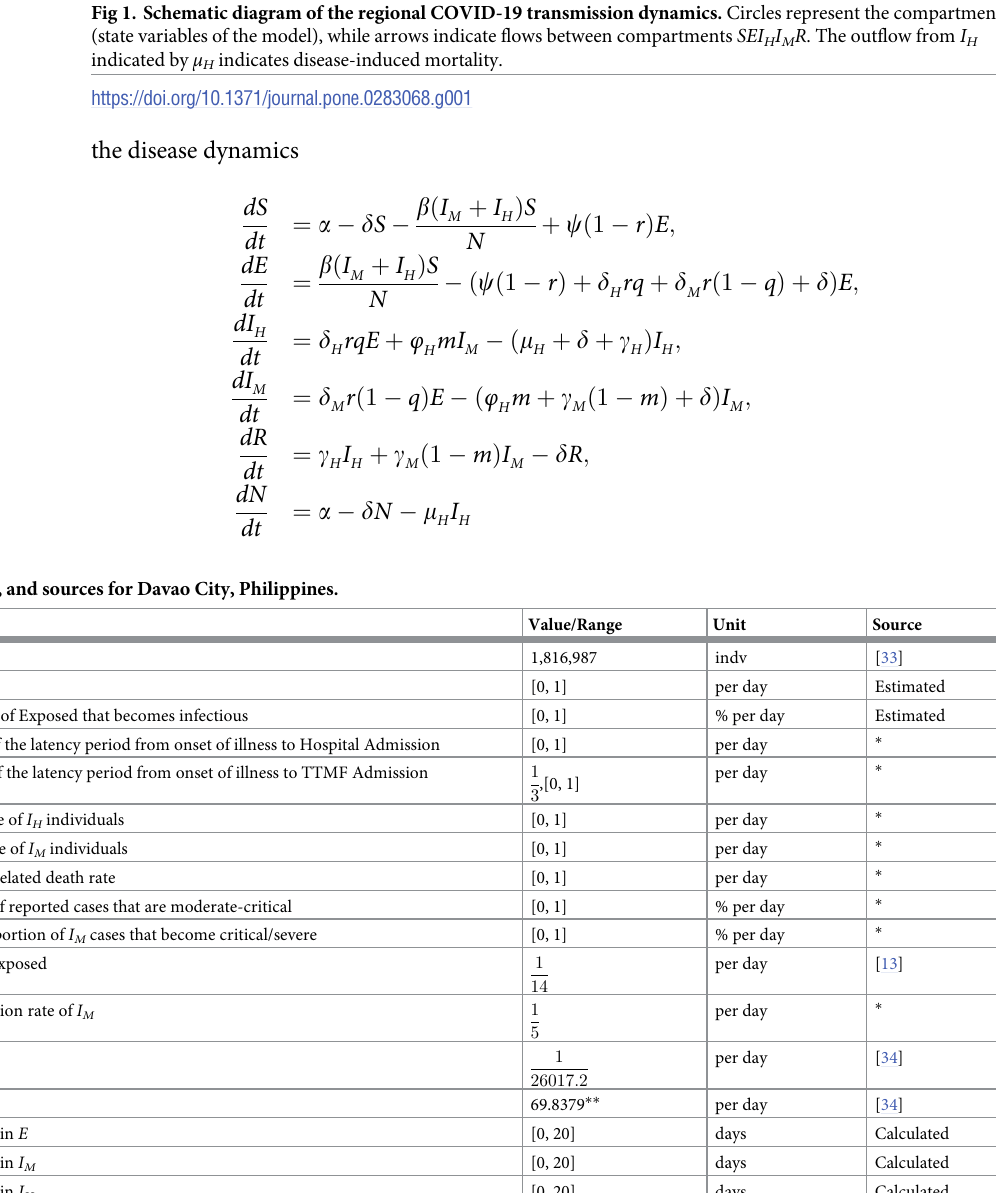
. The outflow from I H I M R H